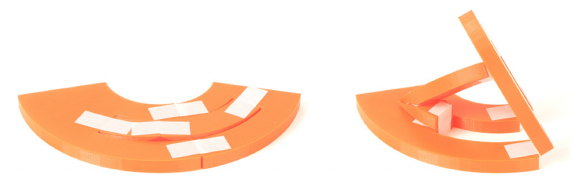
Figure 8. A simplified spherical deploying strut ThUDS based on the general PTHS model (Andrews et al., 2019). Shown in flat and deployed states.